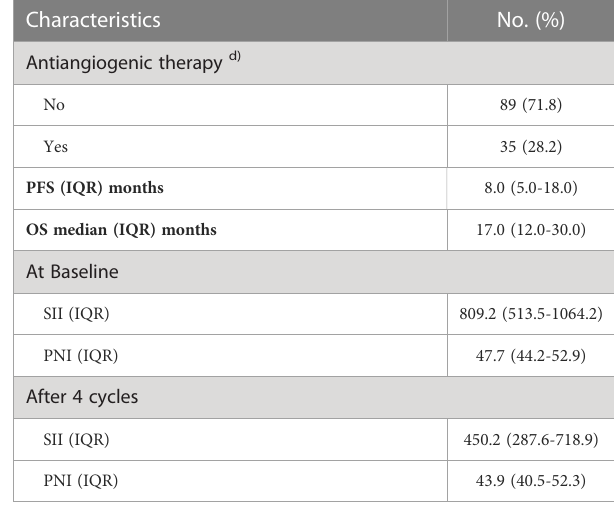
TABLE 1 Clinical characteristics of the